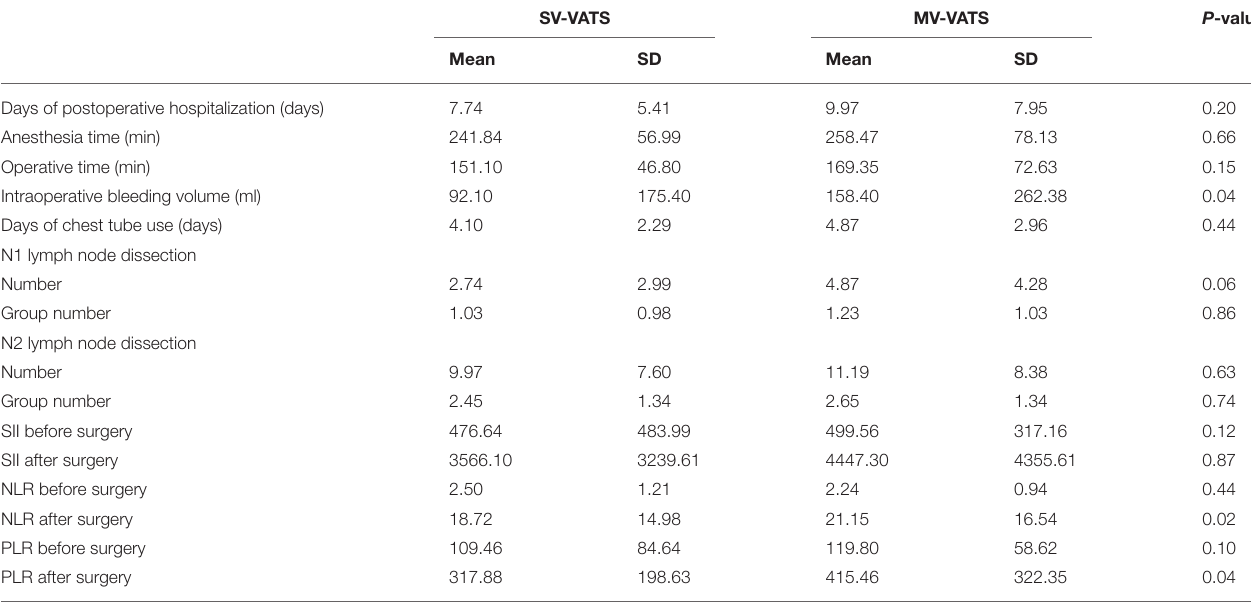
TABLE 2 | Perioperative outcome after 1:2 propensity score matching.